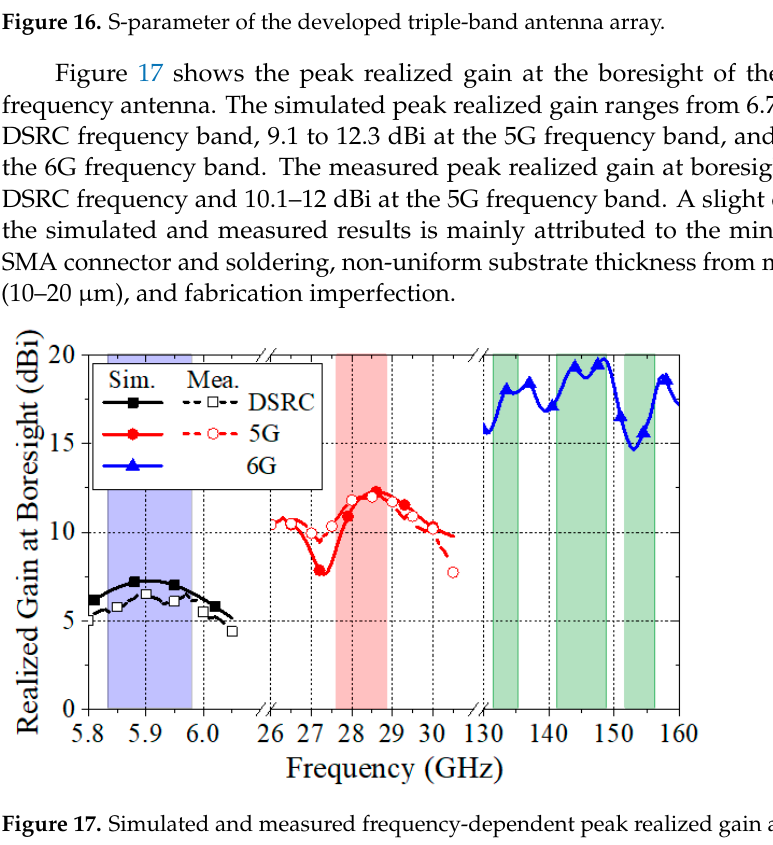
Figure 16. S-parameter of the developed triple-band antenna array.